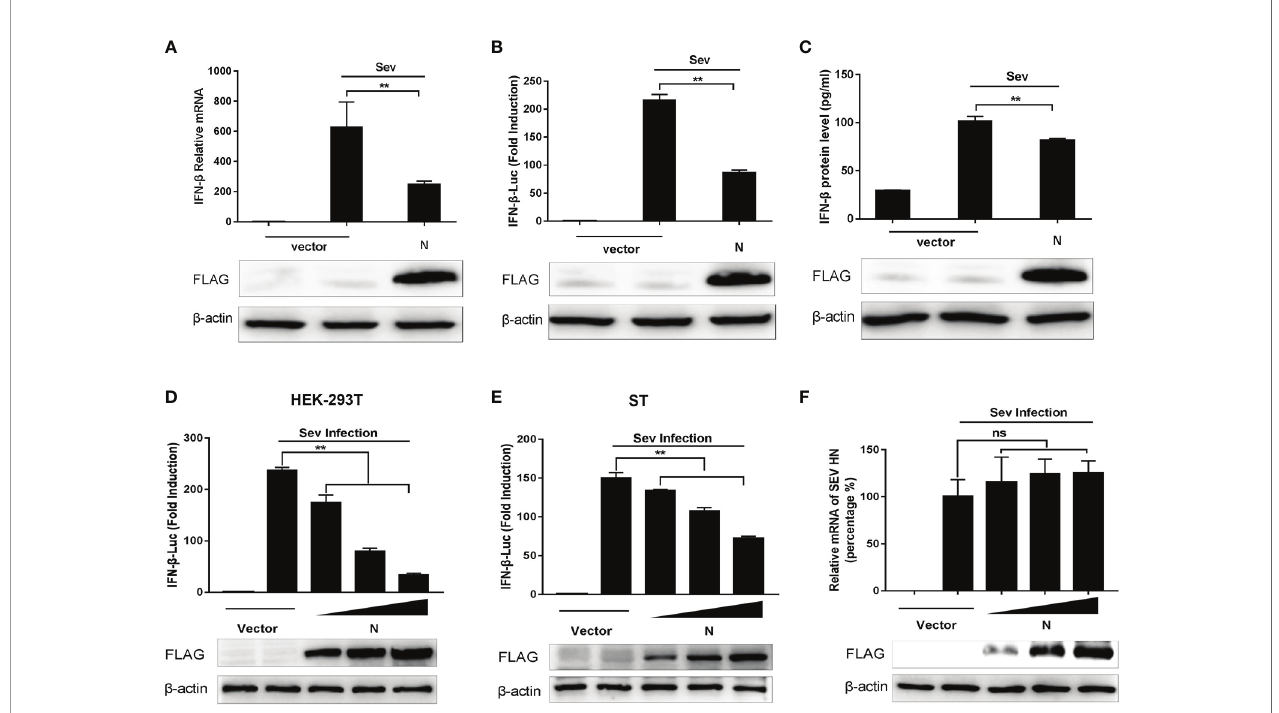
FIGURE 1 | SADS-CoV N protein inhibits Sev-mediated IFN- b expression. (A) HEK-293T cells cultured in 6-well plates were transfected with pCMV-FLAG-N expression plasmids of 2 m g/well. After 24 h, cells were stimulated with Sev for an additional 12 h. And then, total RNA, lysed products, and supernatants were collected separately. The mRNA levels of IFN- b were evaluated by quantitative real-time RT-qPCR. (B) Promoter activities of IFN- b -Luc were analyzed by Dual- Luciferase reporter assay. The relative fi re fl y luciferase activity was normalized to the Renilla luciferase activity, and the value of untreated empty vector was set as 1. (C) The IFN- b protein levels were analyzed by IFN beta Human ELISA Kit. HEK-293T cells (D) or ST cells (E) were co-transfected with the reporter plasmid (IFN- b - Luc) of 0.1 m g/well and internal control plasmid pRL-TK of 0.01 m g/well together with increasing quantities (0.25, 0.5, or 1 m g) of pCMV-FLAG-N expression plasmids for 24 h, and then cells were infected with Sev. The relative activity of the IFN- b promoter was determined by Dual-luciferase assay. (F) HEK-293T cells cultured in 6- well plates were transfected with increasing quantities of pCMV-FLAG-N expression plasmids. After 24 h, cells were stimulated with Sev for an additional 12 h. The total RNA was extracted, and the mRNA expression of the Sev HN gene was evaluated by quantitative real-time RT-qPCR. The expression of SADS-CoV N protein with anti-FLAG antibody was detected by Western blot, and anti- b -actin antibody expression was used as the loading control. ** P < 0.01; ns, nonsigni fi cant differences in